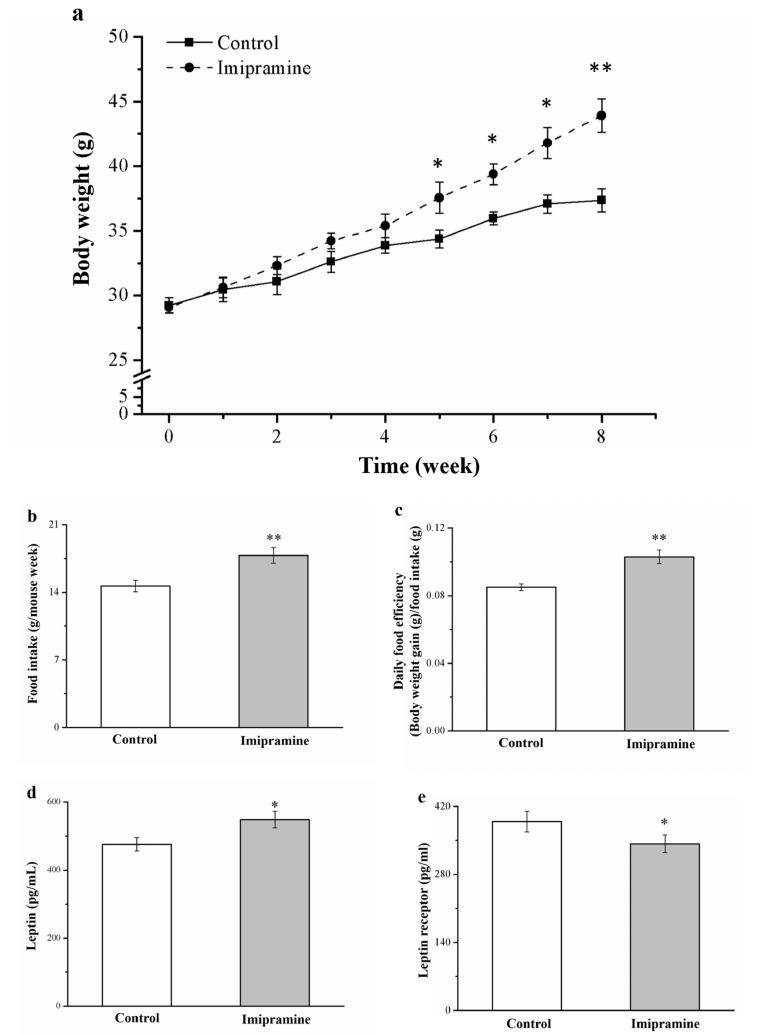
Figure 1. Effects of imipramine on ( a ) weekly body weight changes and ( b ) food intake in each group (measured weekly). ( c ) Daily food efficiency, ( d ) serum leptin levels, and ( e ) leptin receptor levels were measured in HFD-fed controls and imipramine-treated obese mice. For both groups, data are in the form of mean ± standard deviation ( n = 8). * p < 0.05; ** p <